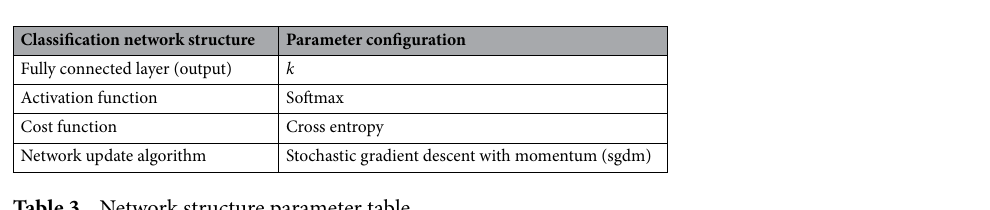
Table 3. Network structure parameter